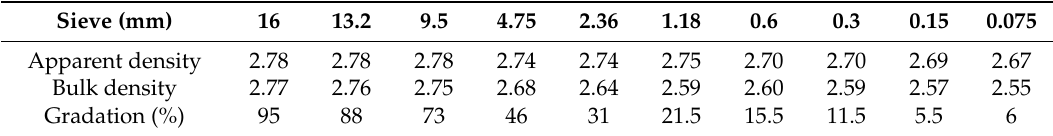
Table 1. Properties of aggregate and gradation of AC-16.